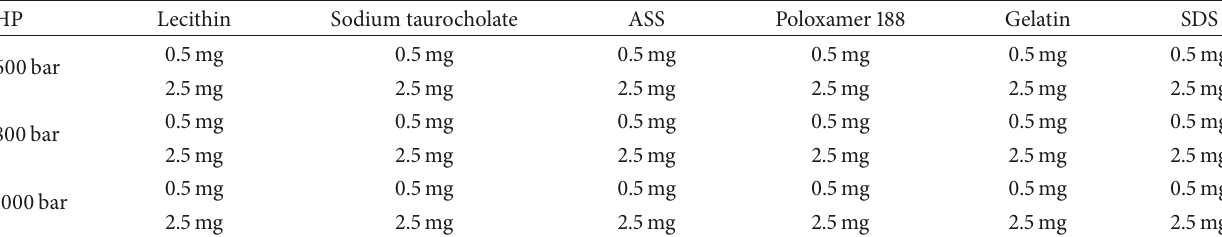
Table 1: Experimental design of preparation of HCPTNPs.